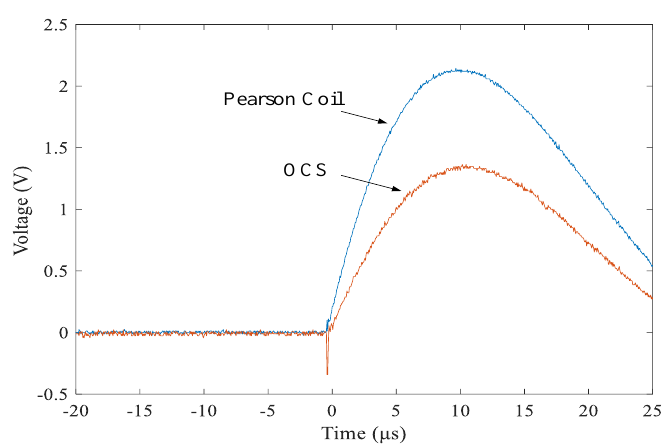
Figure 12. Current waveform measured by OCS.